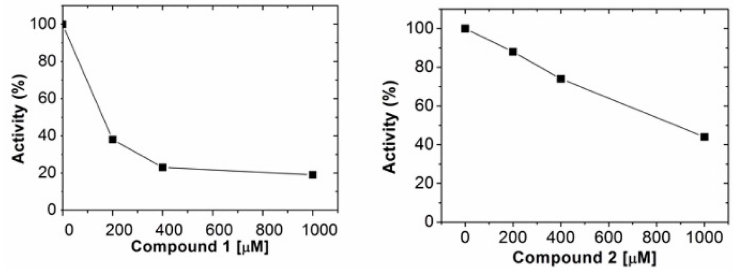
Figure 2. Inhibition kinetics of recombinant HsARG by compounds 1 and 2 .